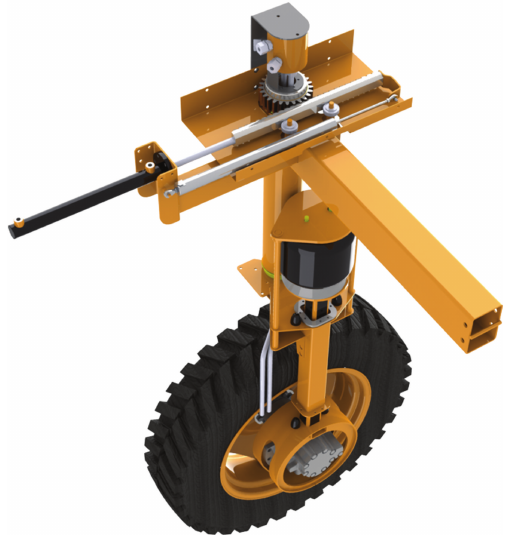
Figure 3: Representation of a wheel module of the robot steering